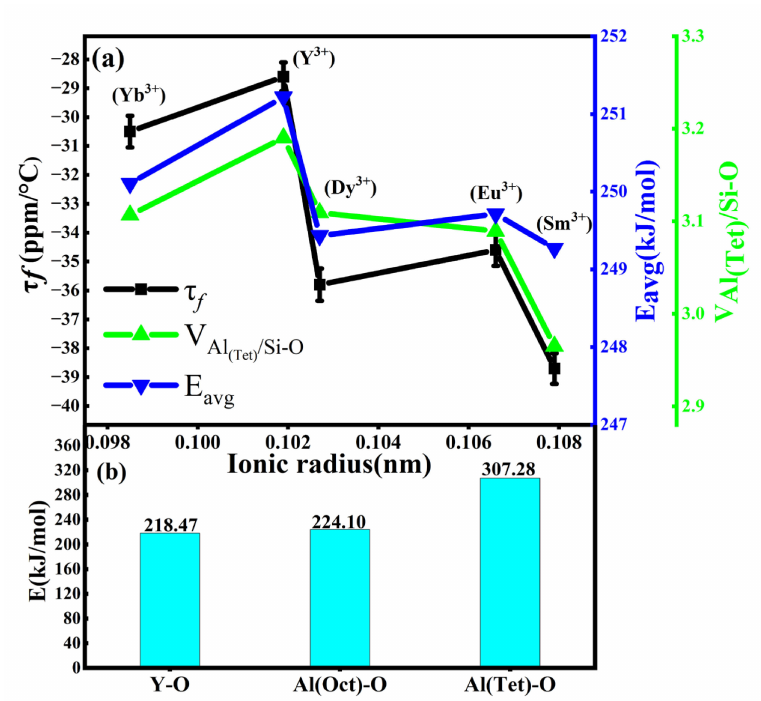
Figure 7. ( a ) The average E, bond valence of V Al/Si-O, and τ f value of Y 2.95 R 0.05 MgAl 3 SiO 12 ceramic; ( b ) Average E of three types of